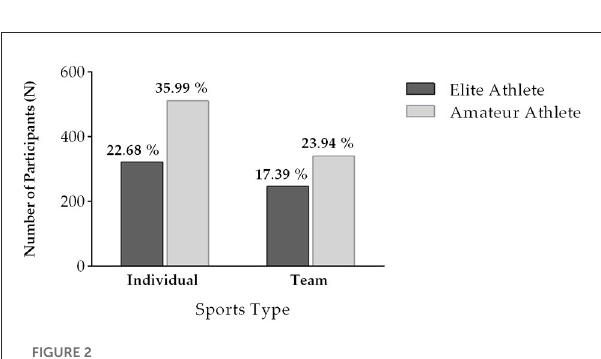
FIGURE2 Bar chart of the type of sport practiced by the sample of elite and amateur athletes.